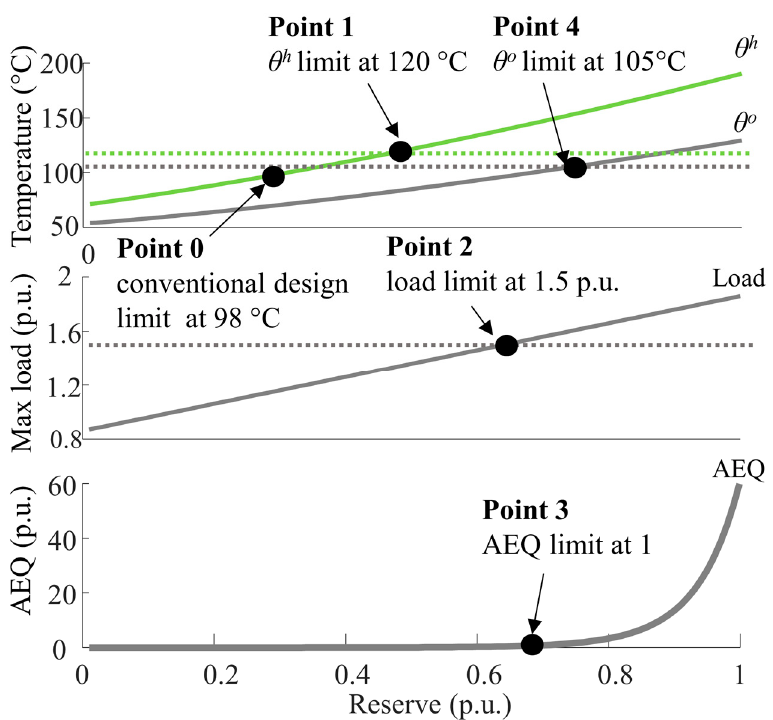
Figure 3. Preliminary thermal results for yearly simulation: load growing from 1% to 100% of nominal rating (reserve in p.u.). The initial loading of the studied distribution transformer is 86% (see the y -axis of the middle figure).